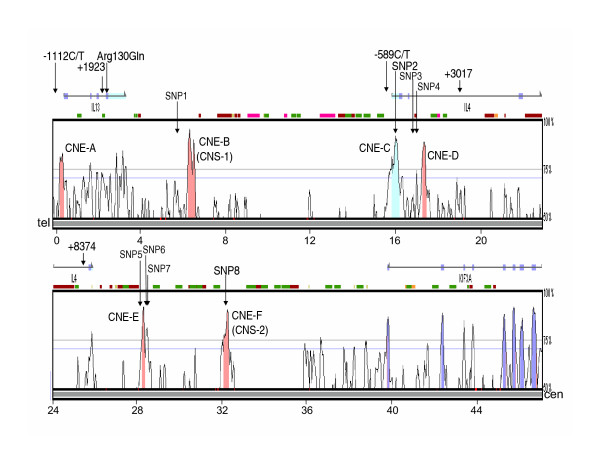
VISTA plot [24] displaying evolutionarily conserved sequences identified by the comparison of ~48 kb of human 5q31 DNA encoding the IL4, IL13 and KIF3A genes with murine sequences (BAC clone AF276990). On the horizontal axis, conserved sequences are plotted in relation to their position in the human reference sequence; kb distances are shown under the horizontal bar. The height of the peaks on the vertical axis indicates the level of conservation in percent identity between the human reference sequence and the murine sequences. Conserved sequences (>100 bp and >70% identity) defined as coding exons (dark blue), untranslated exons (light blue) and non-coding (red) are shown. The exons in each of three genes are shown as rectangle boxes; only the 3' end (exons 9 through 16) of KIF3A is shown. Six conserved non-coding elements were examined in this study (CNE-A - CNE-F). The SNPs identified or genotyped in this study and their approximate locations are shown. CNE-B corresponds to CNS-1 and CNE-F corresponds to CNS-2 described by Loots et al. [4].